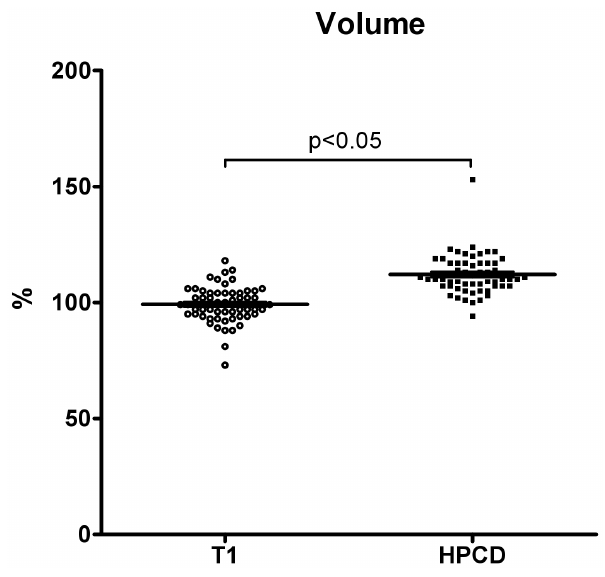
Figure 4. Volume escape from Ringer perfusion fluids with and without HP-ß-CD at a flow rate of 2 m L/min and a collection